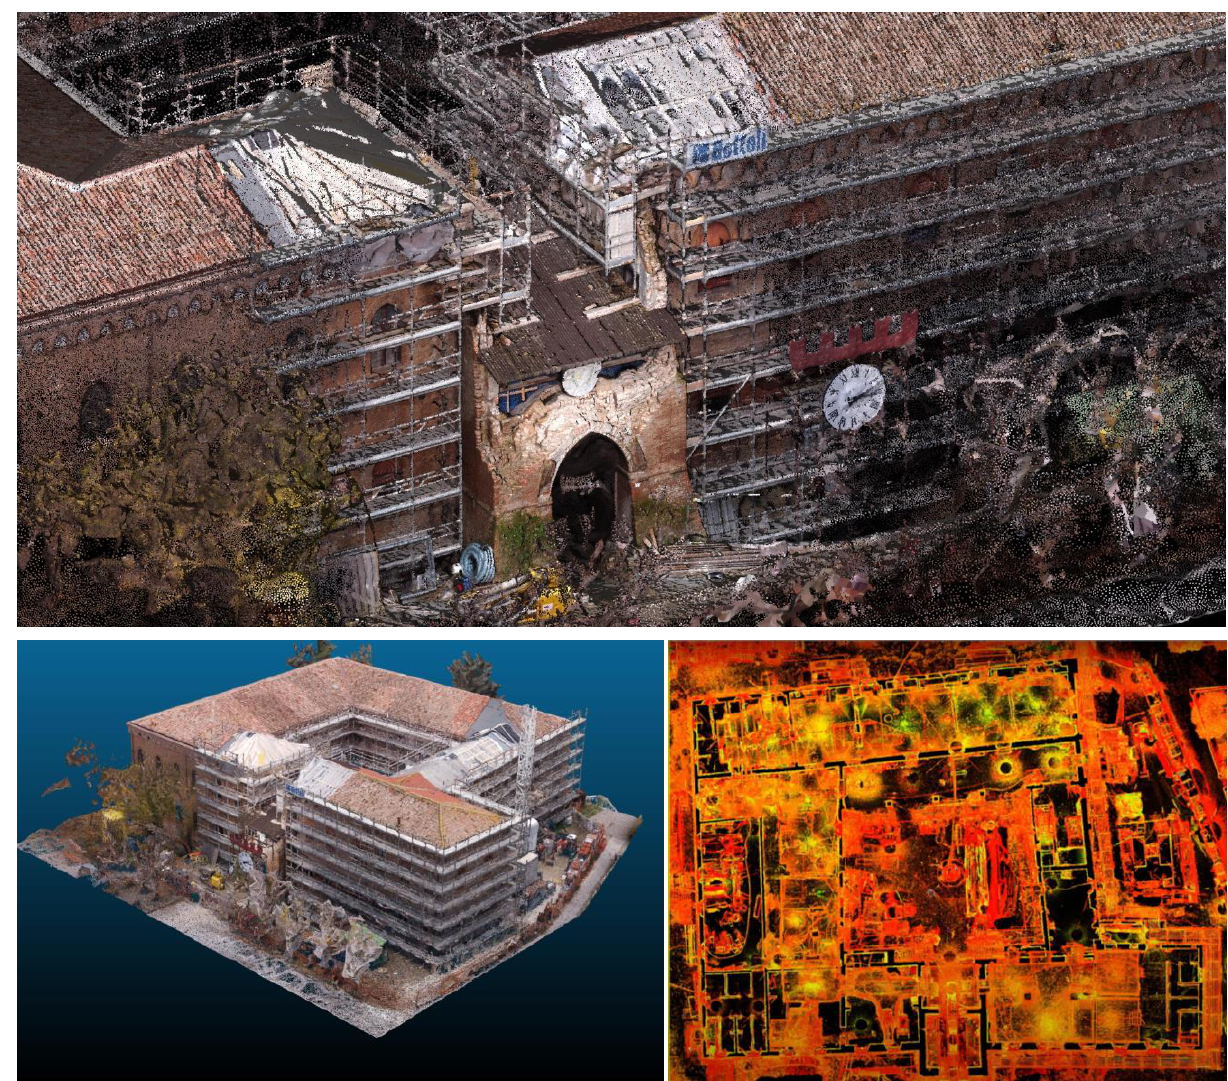
Figure 3. Integrated three-dimensional digital survey of earthquake-damaged cultural heritage. Palazzo Lambertini, Poggio Renatico,